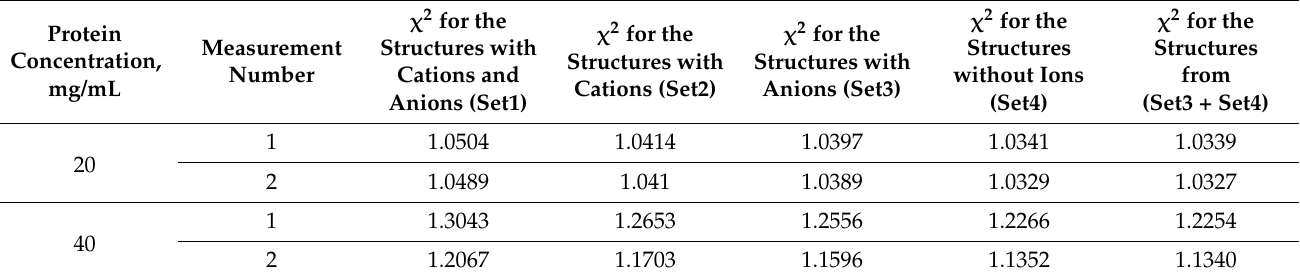
Table 2. SAXS fit qualities ( χ 2 ) obtained using the lysozyme oligomeric models with the different occupancy of cations (Cu 2+ ) and anions (Cl − ). For each protein concentration, the data from two independent measurements (1 and 2) are given. The best fit qualities χ 2 are shown in bold. The structures based on PDB ID: 6QWW are